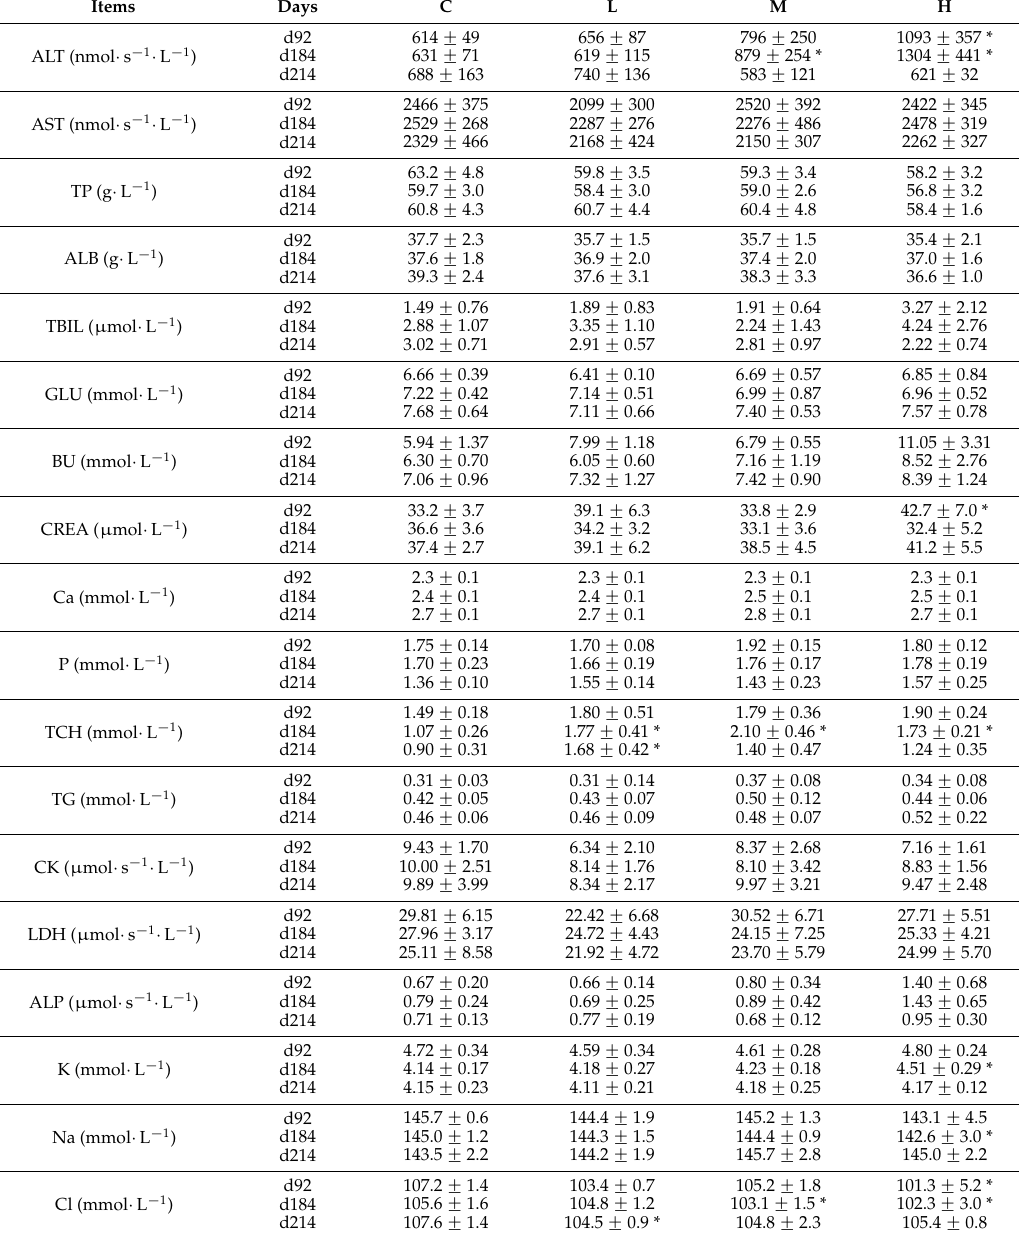
– x ˘ SD, d92 n = 5, d184 n = 10, d214 n =